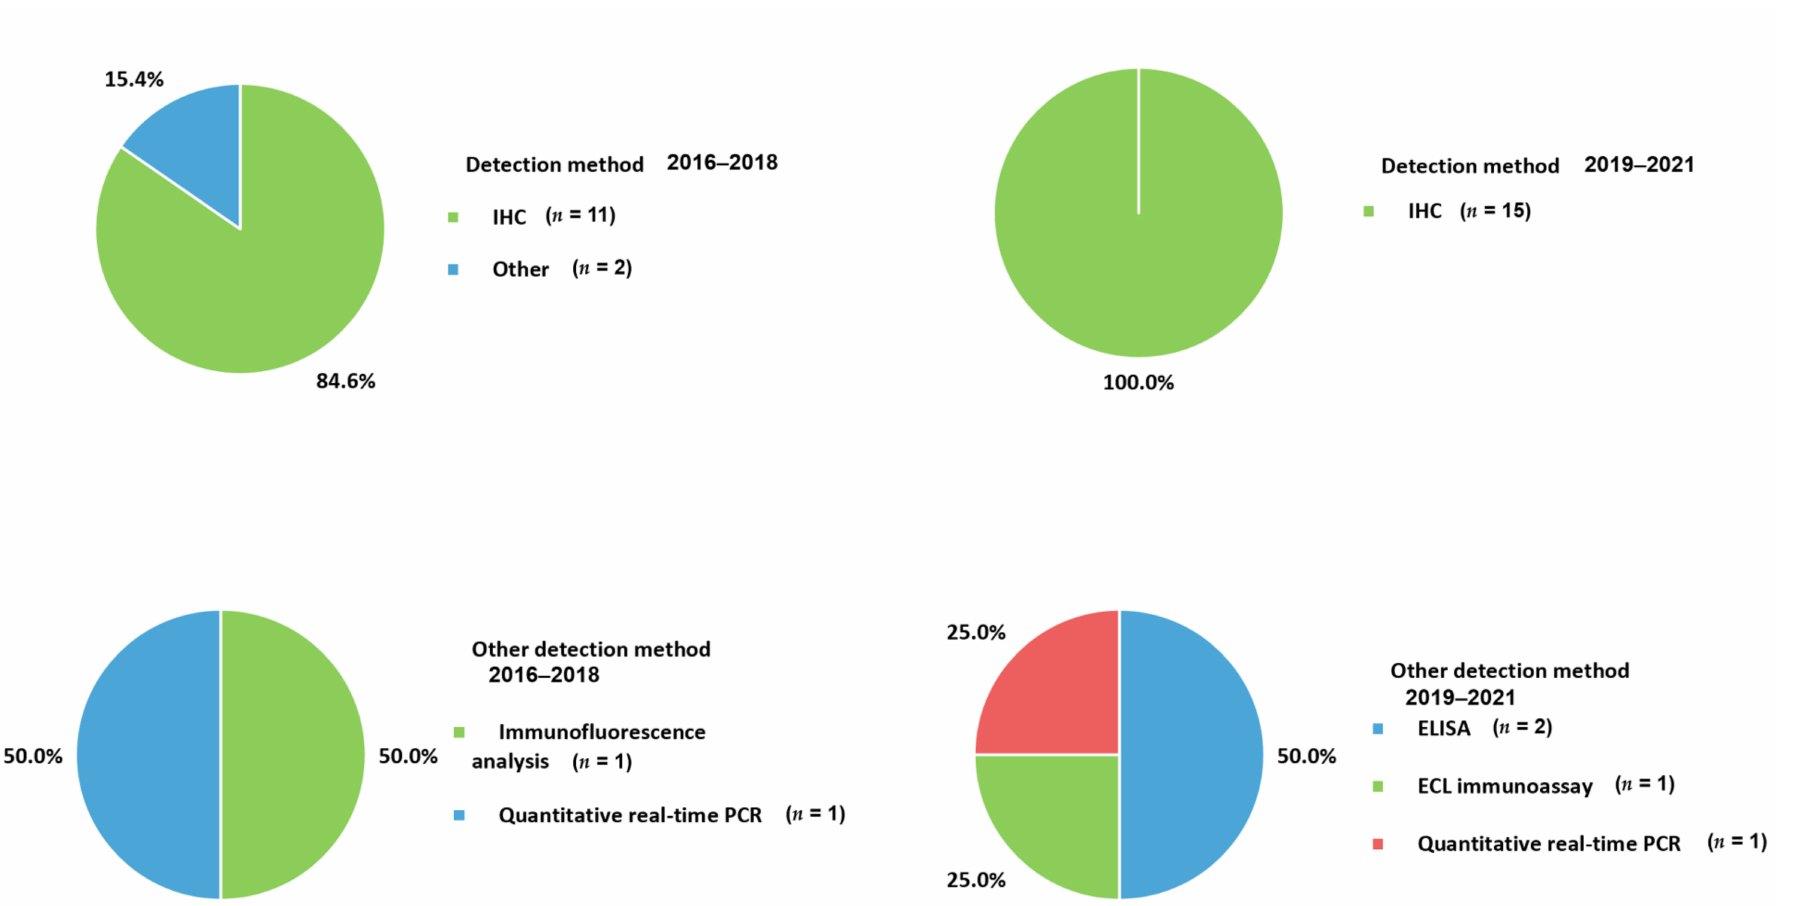
Figure 8. Changes in applied methods for detecting the PD-1 axis. ( A ) Pie charts presenting the changes in detection method; ( B ) pie charts showing the changes in other methods for detecting the PD-1 axis. PD-1, programmed cell death protein-1; IHC, immunohistochemistry; ECL, electrochemiluminescence; ELISA, enzyme-linked immunosorbent